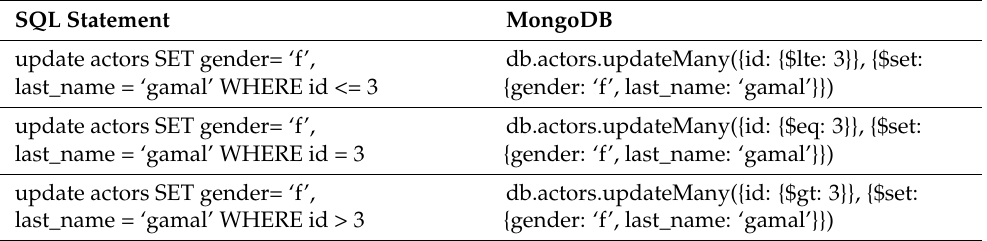
Table 3. Translate UPDATE statements from SQL to MongoDB the using proposed layer.